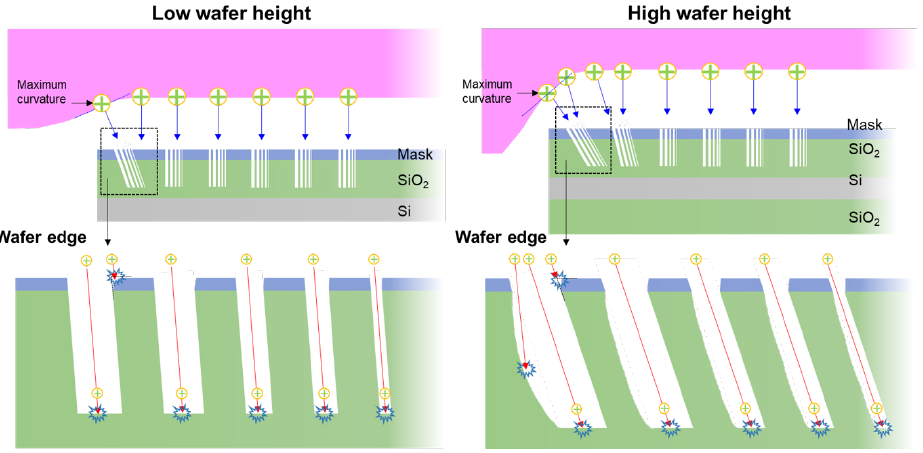
Figure 5. A schematic of the mechanism of the etch distortion according to the wafer height and contact hole size.